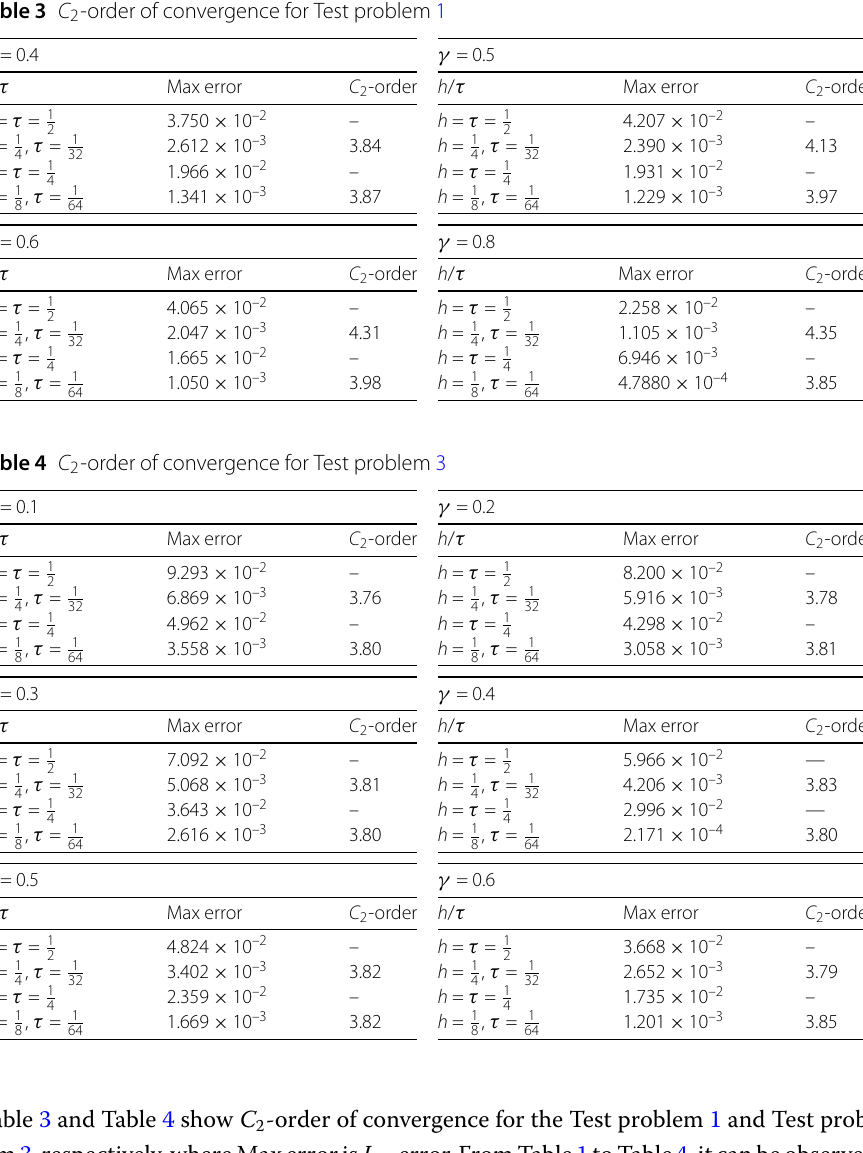
Table 3 and Table 4 show C 2 -order of convergence for the Test problem 1 and Test